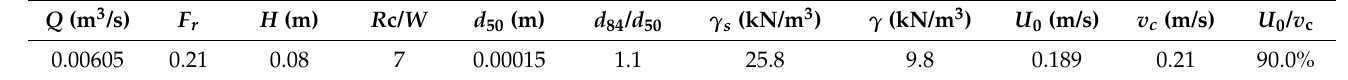
Table 2. Summary of experimental